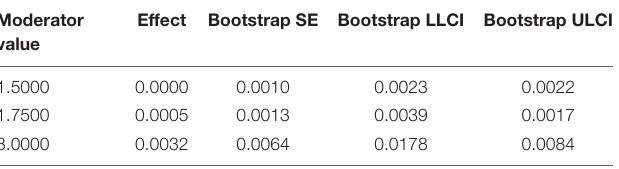
behavior for the environment. Number of bootstrap samples = 520; Level of Confidence = 95%.